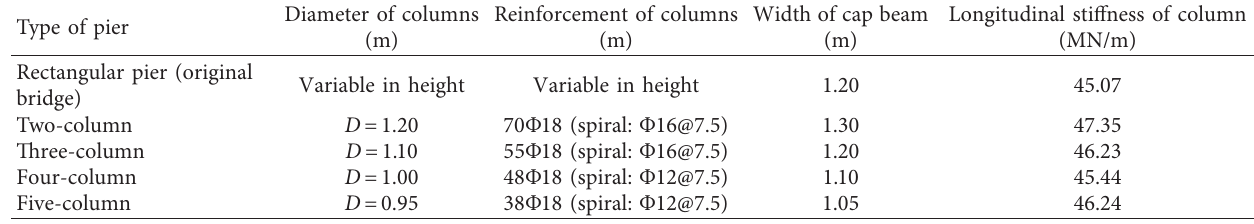
Table 1: Dimensional and reinforcement details of the pier systems.